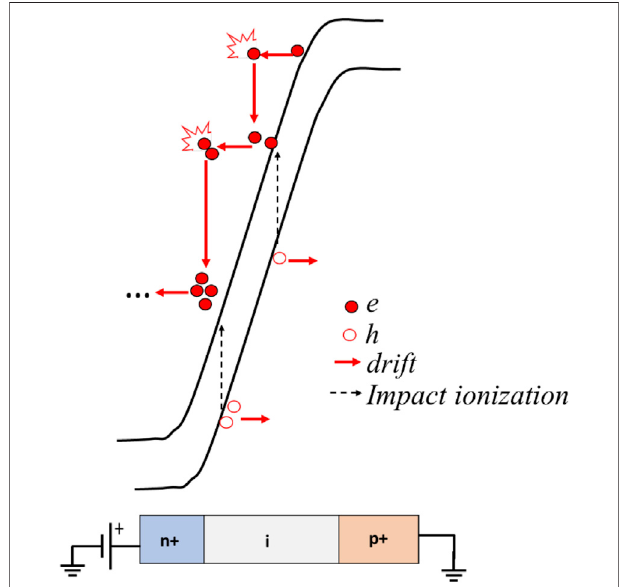
FIGURE 1| Impact ionization process in a reverse-biasedp-i-n junction.